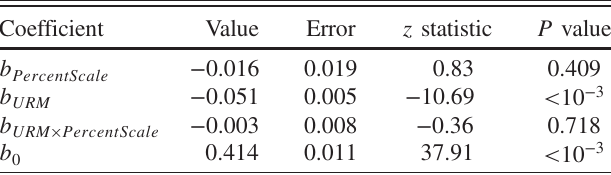
TABLE II. The coefficients from an HLM fit to Eq. (1) are shown along with their standard errors, z statistics, and P values.